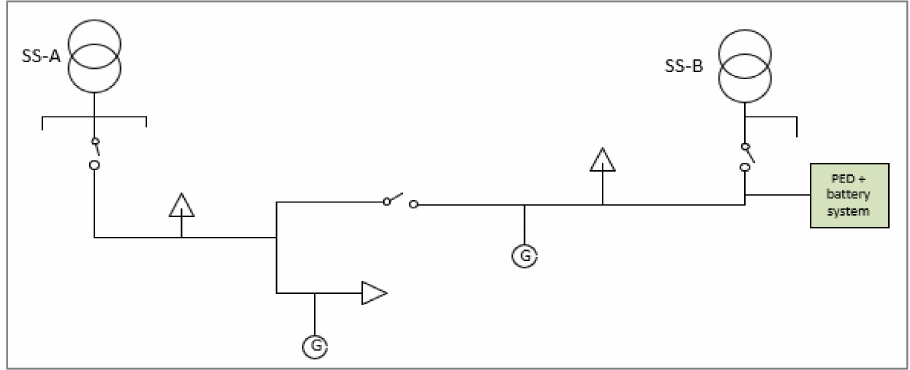
Figure 4. Simple pilot schematic showing the location of PED connection. Smart meters and power quality monitors installed at the beginning of the two feeders and in the point of common coupling of the PED were installed to collect data used during the validation phase. The PED and the batteries were installed in the SS-B (Figure 5). This location has been selected for space reasons, as it consists of a two-floor building, with an empty second floor. Both the PED and batteries through the battery management system (BMS) were integrated with the SCADA through specific remote terminal unit